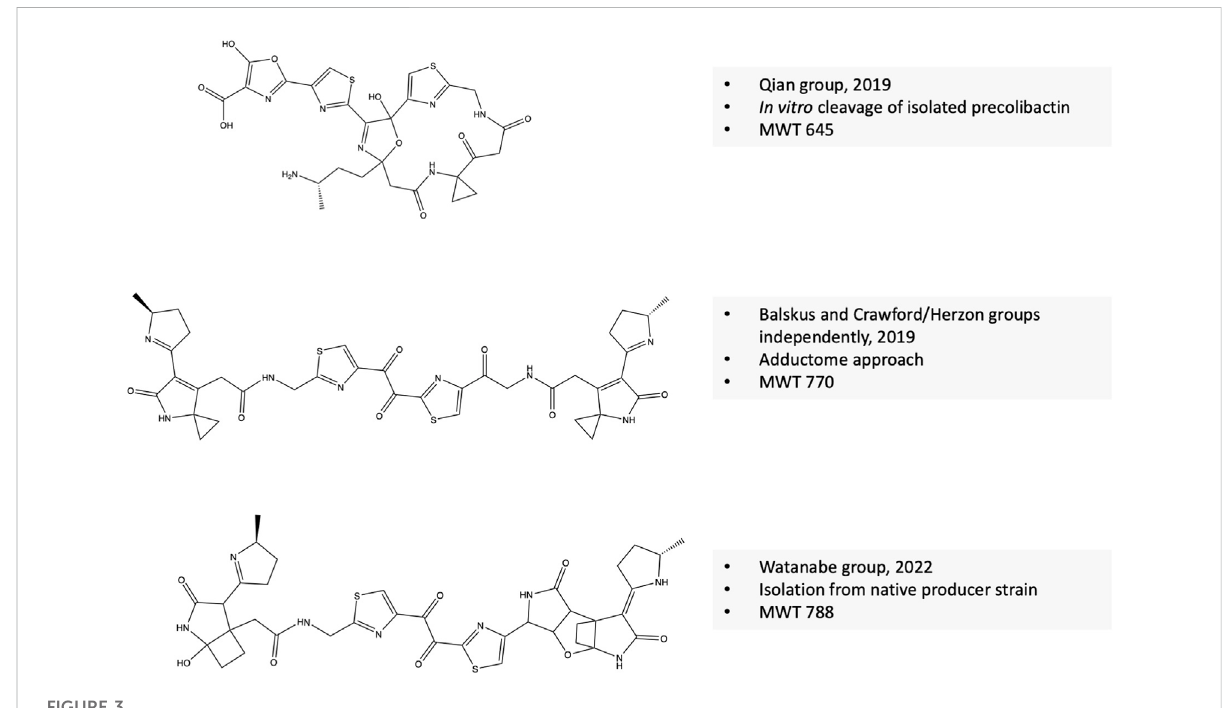
FIGURE 3 Con fi rmed structure of